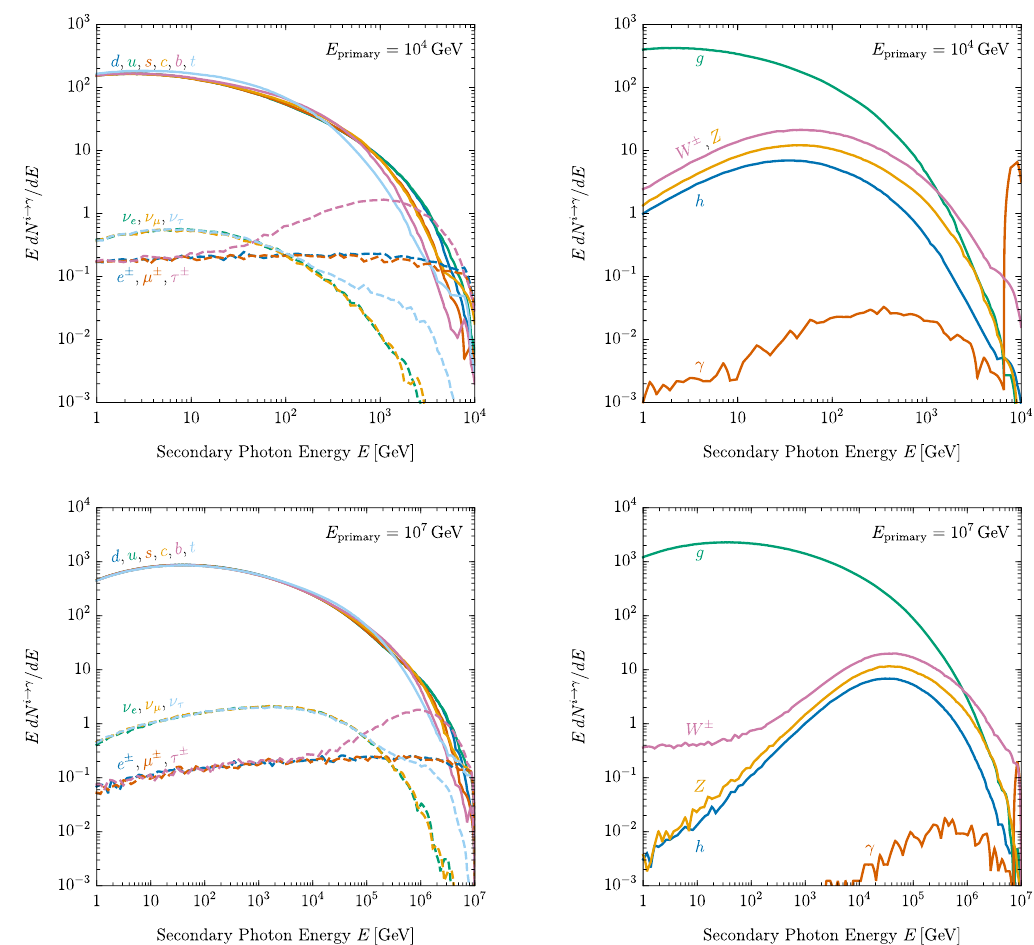
Figure 5 . The secondary photon spectra per primary particle for the SM fermions (left) and bosons (right) at a primary energy of 10 4 GeV (top) and 10 7 GeV (bottom). The artefacts are Monte Carlo error for rare processes and do not lead to a significant error in the total secondary